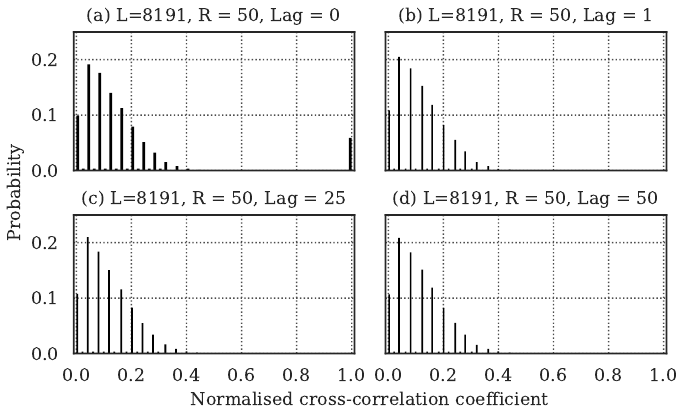
Figure 2. Cross-correlation statistics for 50 chip subsequences of 16 × 8191 chip binary m-sequence set with ( a ) zero lag, ( b ) 1 chip lag, ( c ) 25 chip lag, ( d ) 50 chip (1 symbol)